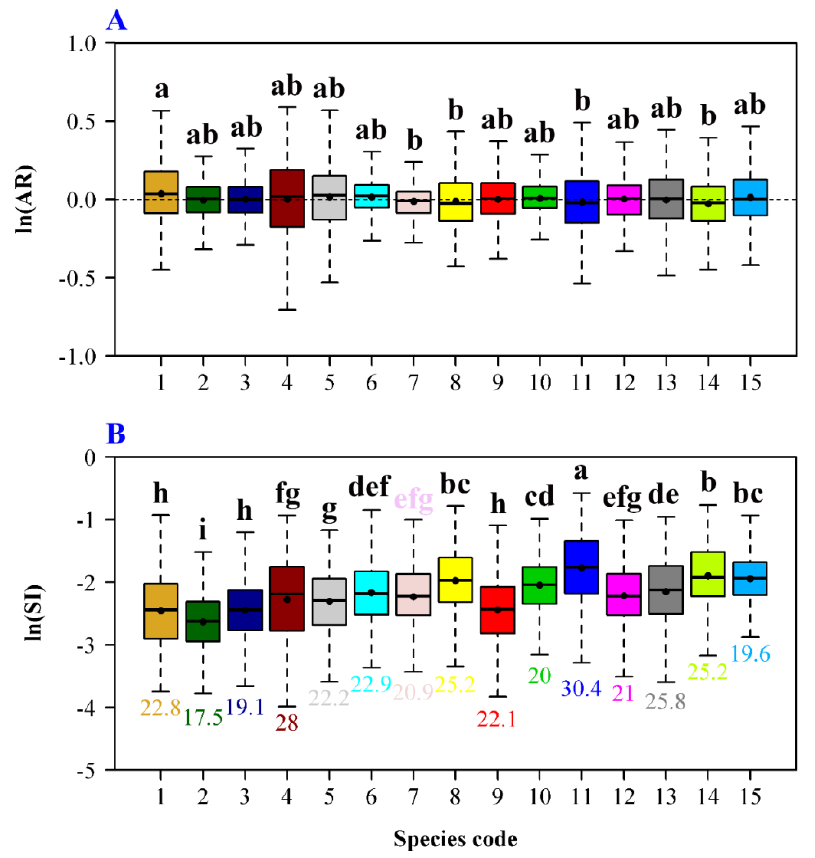
Figure 3. Boxplots of the natural logarithm of the areal ratio (AR) of the left side to right side of a leaf ( A ), and the natural logarithm of the standardized index (SI) for measuring leaf bilateral symmetry ( B ). In panel B, the numbers below the whiskers of boxes represent the coefficients of variation of ln(SI). The bold segments in the boxes represent the medians, and the points near the bold segments represent the means. Different colors represent different species of vines.